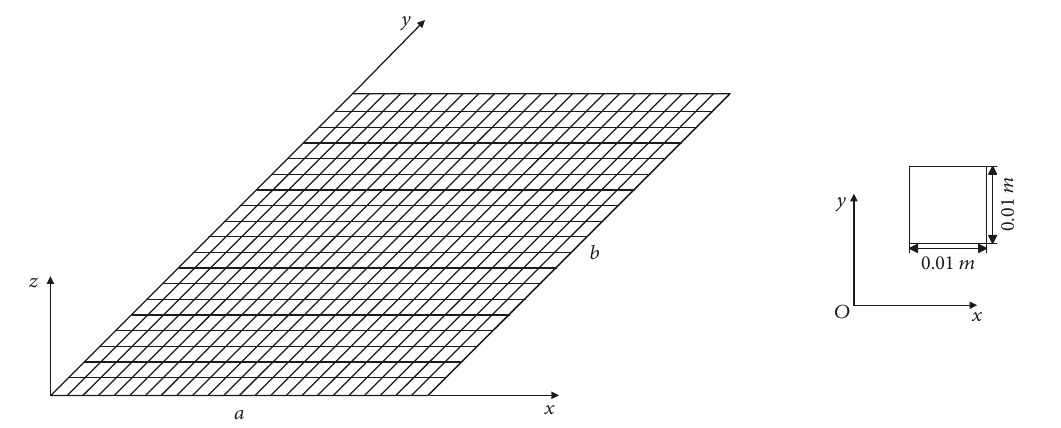
Figure 2: The structural fi nite element mesh with uni fi ed grid cells.